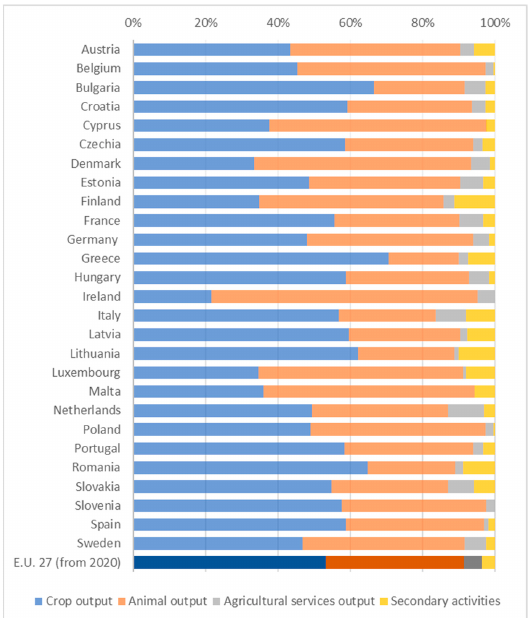
Figure 6. The total agricultural output structure for each member state, 2020. Source: Authors’ calculation and representation, according to Eurostat (2020) data. Table 10. Factor income determination using specific indicators (million euro).